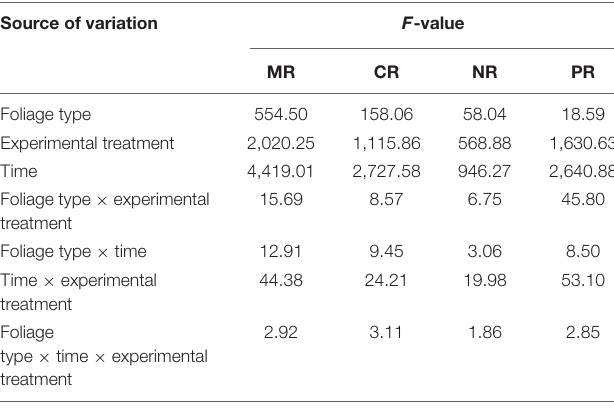
TABLE 2 | Analysis of variance (ANOVA) results for the foliage and TOC, TN, and TP remaining during the decomposition process. Source of variation F -value